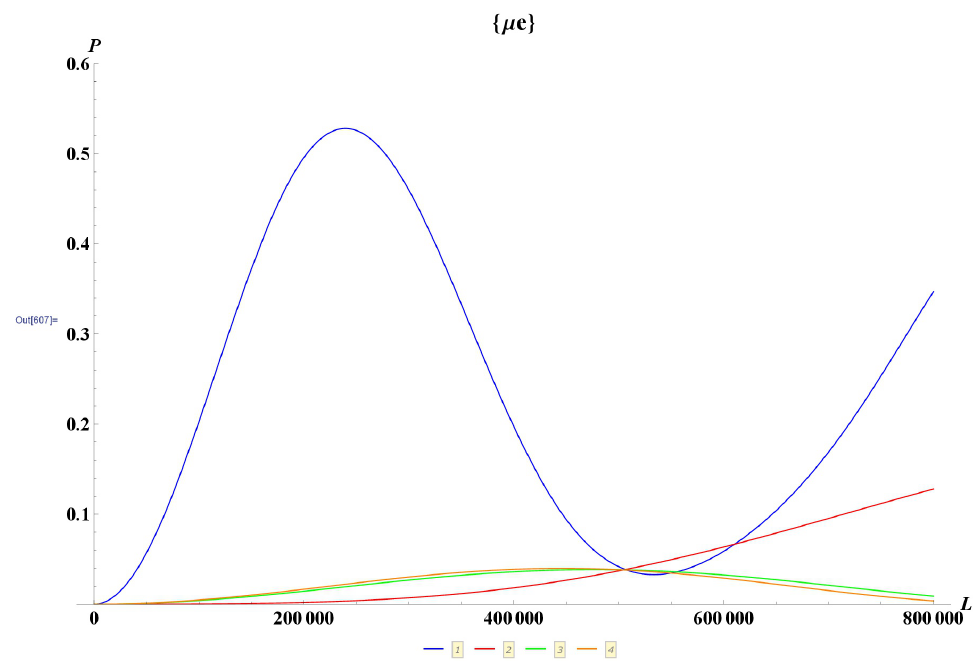
Figure 8. P ν oscillation probability, as function of baseline L, for neutrino energy E = 1TeV, for µ ν e “classical theory”, LI (orange curve) and for LIV models, with parameters equal respectively to δ f 32 = δ f 21 = 4.5 × 10 − 27 (blue), δ f 32 = δ f 21 = 4.5 × 10 − 28 (red) and δ f 32 = δ f 21 = 4.5 × 10 − 29 (green curve). Baseline L in km